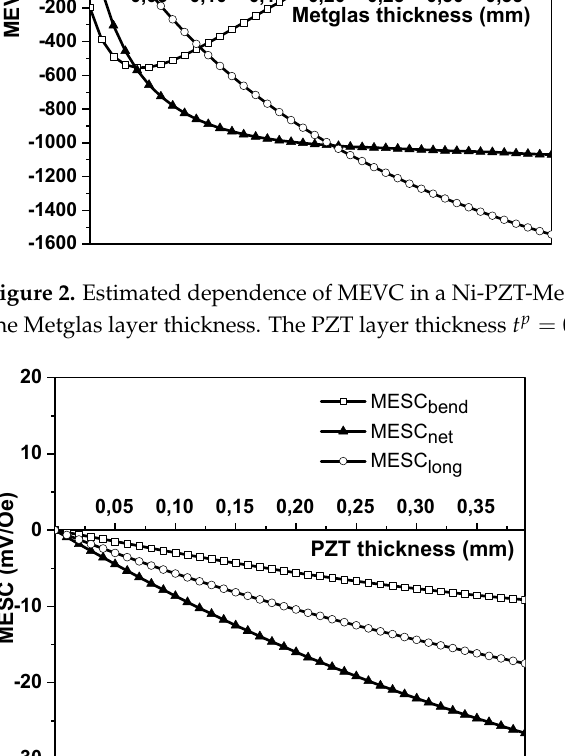
Figure 3. Estimated dependence of MESC in a Ni-PZT-Metglas first-type three-layered structure on the PZT layer thickness. The Ni layer thickness 𝑡 (cid:3040)(cid:2869) = 0.2 mm , the Metglas thickness 𝑡 (cid:3040)(cid:2870) = 0.2 mm.